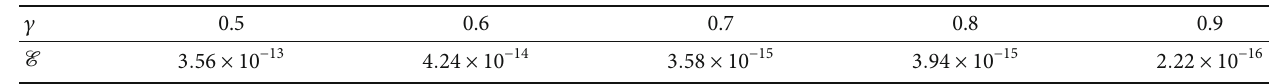
Table 2: Residual error of example 2.